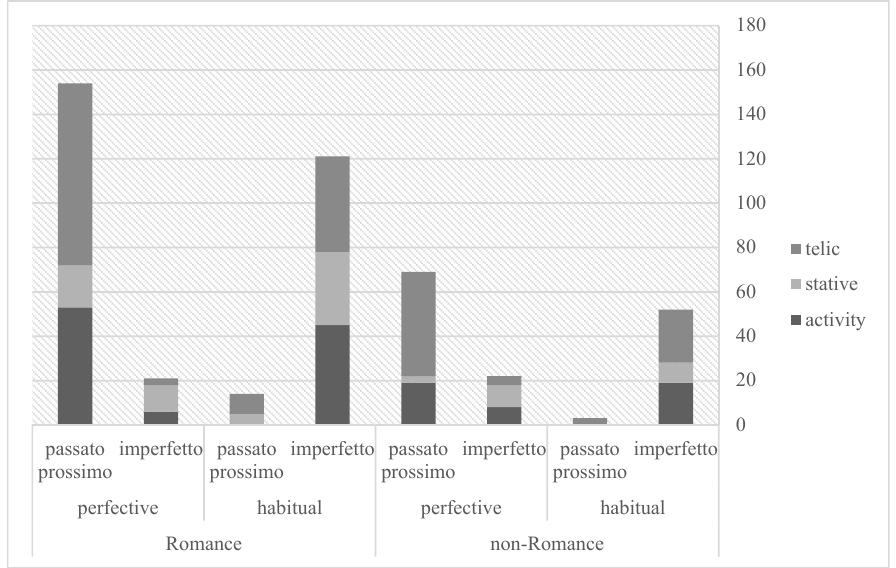
Figure 2. Number of occurrences of passato prossimo and imperfetto in perfective and habitual con- texts produced by high-proficiency learners according to lexical aspect (telic, stative, activity) and knowledge of a Romance language L2 (Romance, non-Romance).